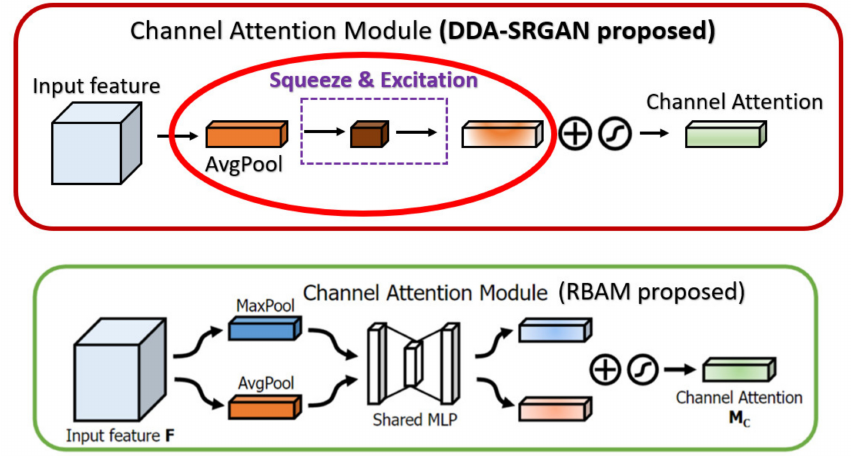
Figure 21. The main difference between the RBAM and DDAB in terms of channel attention module. The red solid circle indicates the different implementation in our module